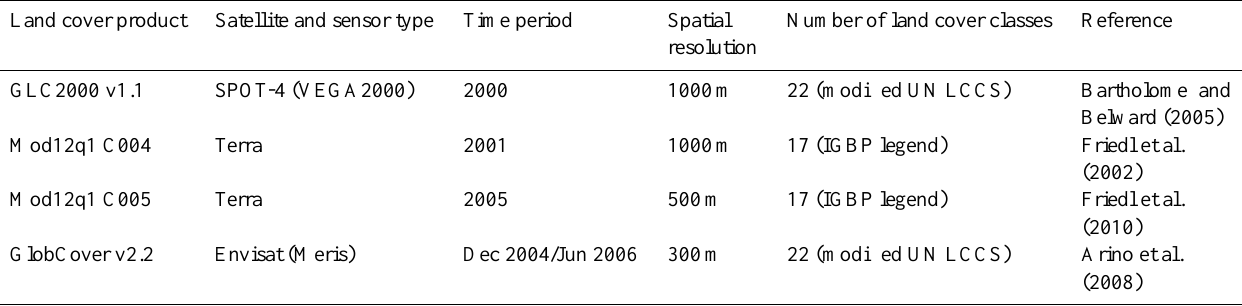
Table 2. Remotely sensed land-cover data sets and their corresponding spatial resolution and classification approach (where IGBP is the International Geosphere Biosphere Program, and UN LCCS is the United Nations Land Cover Classification